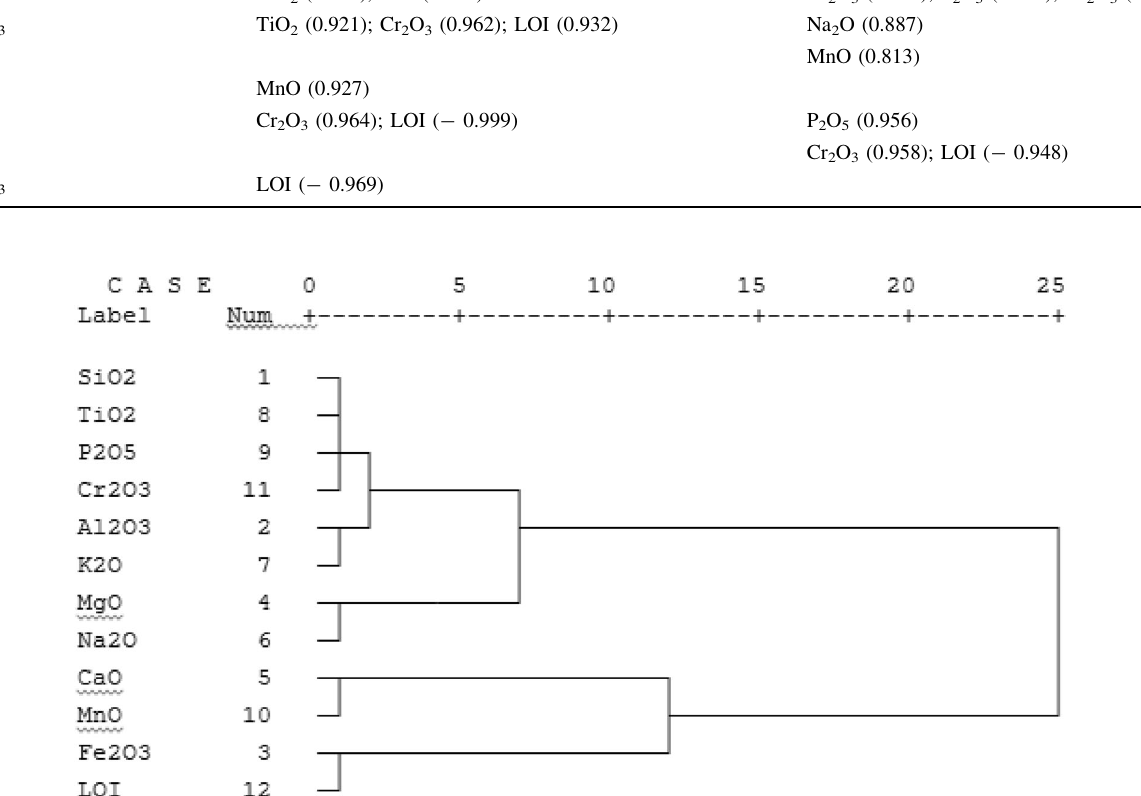
Fig. 7 Cluster yield of major oxides of coal